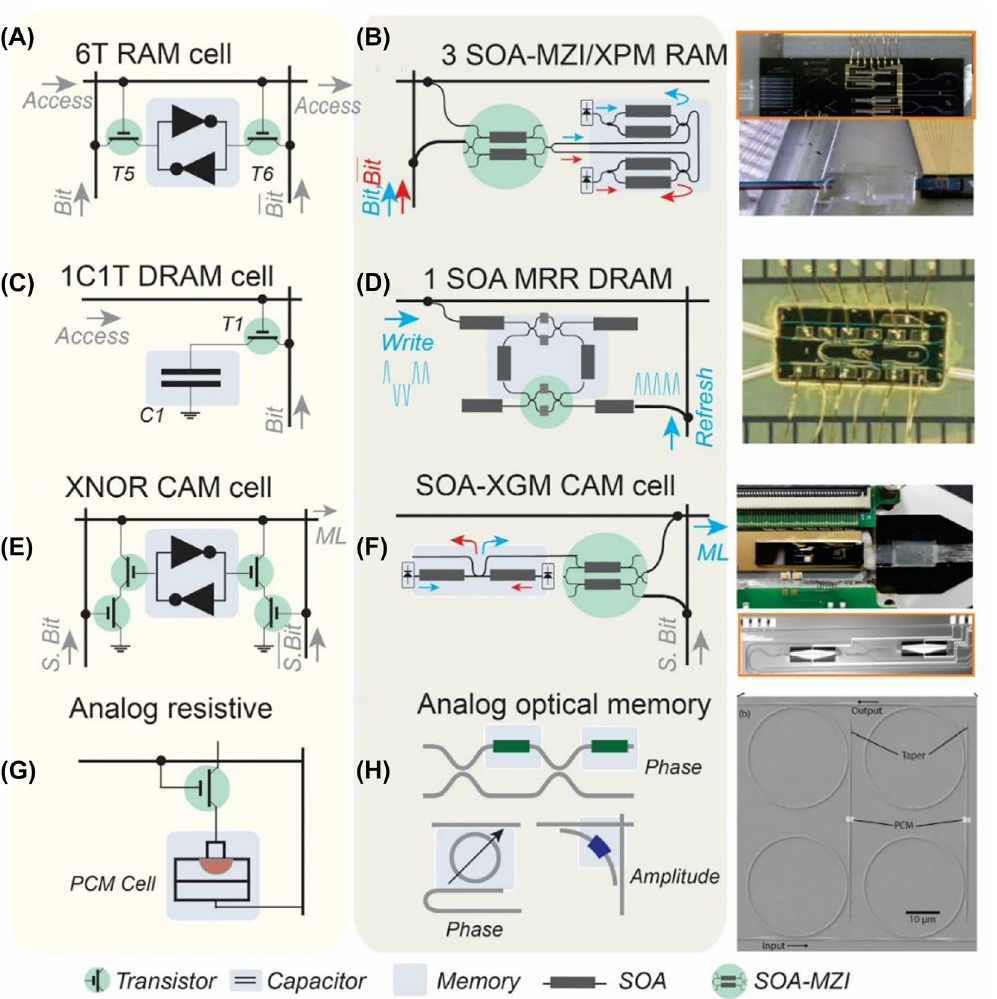
Figure 12: Comparison of electronic and photonic SRAM, DRAM, CAM, and analog cell architectures: (A) conventional electronic 6T RAM cell architecture, (B) integrated photonic RAM cell architecture based on three SOA-MZI XPM gates and inset-photo of a fabricated device [145], (C) conventional electronic DRAM cell architecture with 1capacitor and 1 transistor, (D) integrated photonic DRAM cell architecture and